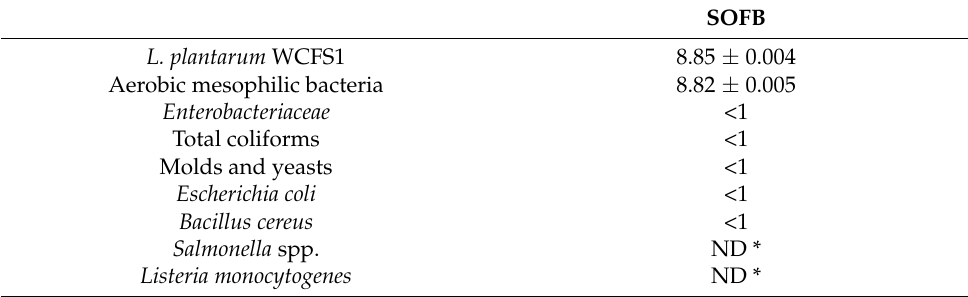
Table 2. Viable microbial counts (Log CFU/mL) in